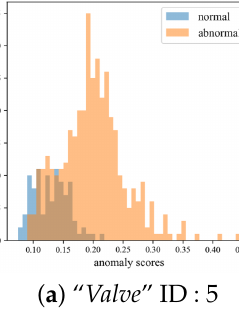
Figure 4. Distribution of anomaly scores of the machine “ Valve ”. ( a , b ) are different machines of the same types. ( b ) shows that the model completely distinguishes normal and anomalous sounds, but ( a ) does